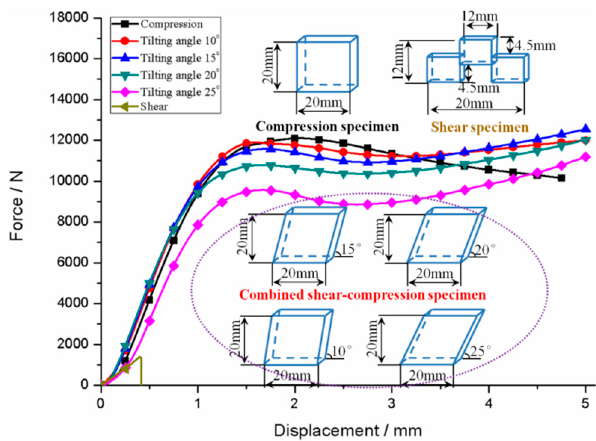
Figure 1. Force-displacement curves and schematic of poly(methyl methacrylate) (PMMA) specimens used in quasi-static loading.